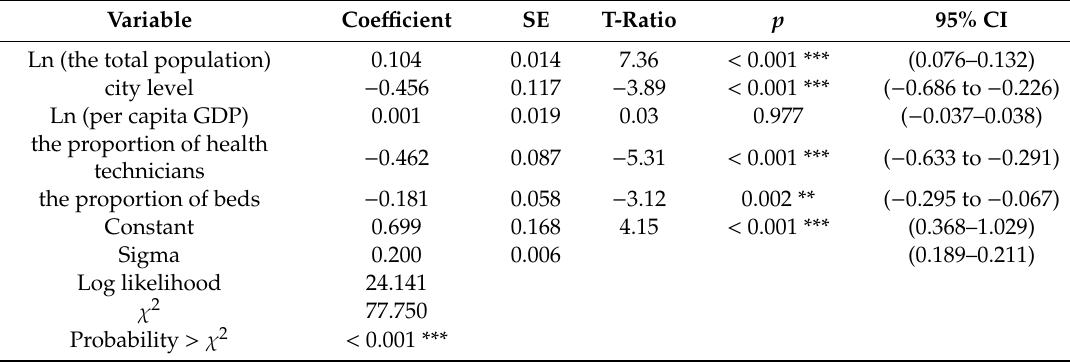
Table 5. Results of Tobit regression ( N = 774).